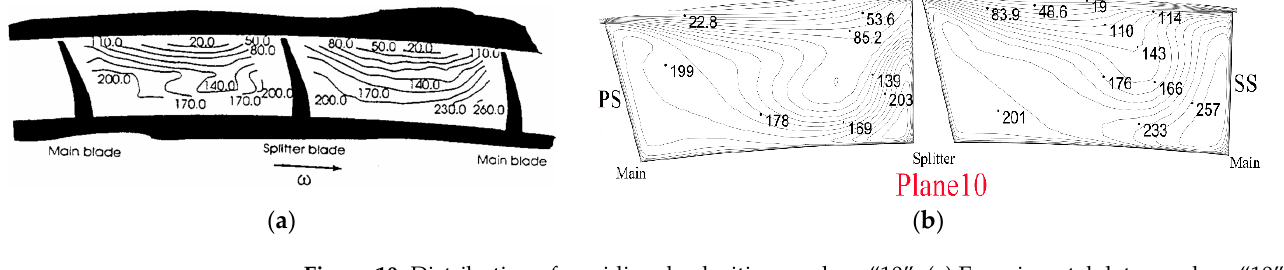
Figure 10. Distribution of meridional velocities on plane “10”. ( a ) Experimental data on plane “10”. ( b ) Numerical results on plane “10”.